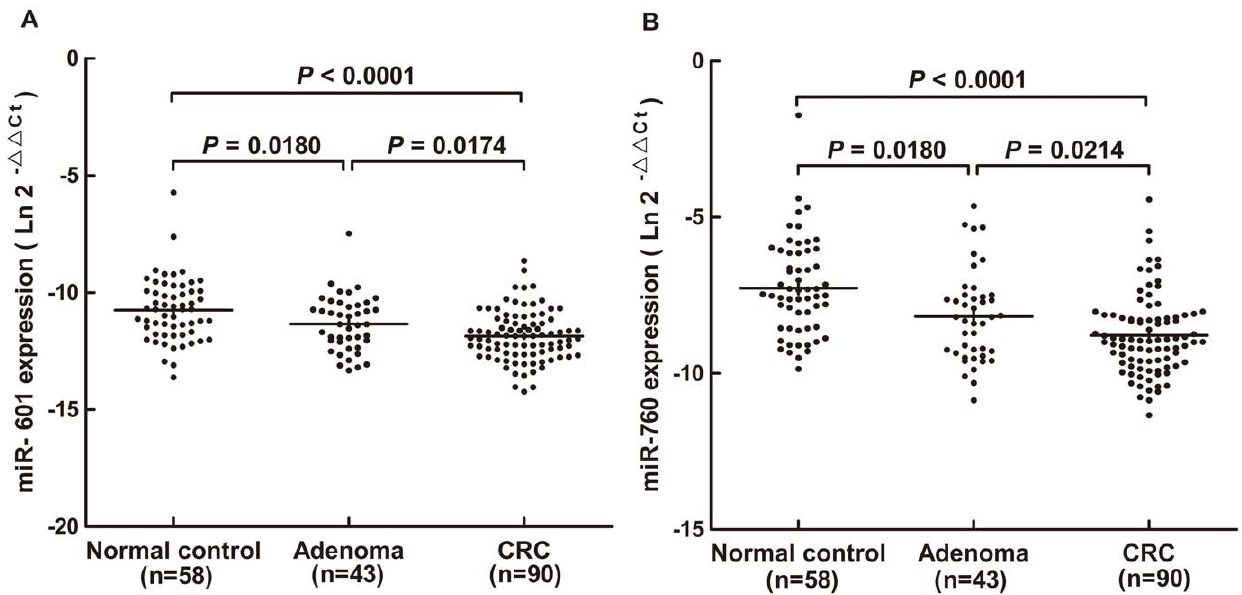
Figure 1. Plasma miR-601 and miR-760 expression. Large-scale validation of miR-601 and miR-760 in plasma samples (n=191). Scatter plots of plasma levels of miR-601(A) and miR-760(B) in healthy subjects (n=58), advanced adenomas(n=43) and CRC patients(n=90). Expression levels of the miRNAs were normalized to cel-miR-39. The line represents the median value. Mann-Whitney U test was used to determine statistical significance.